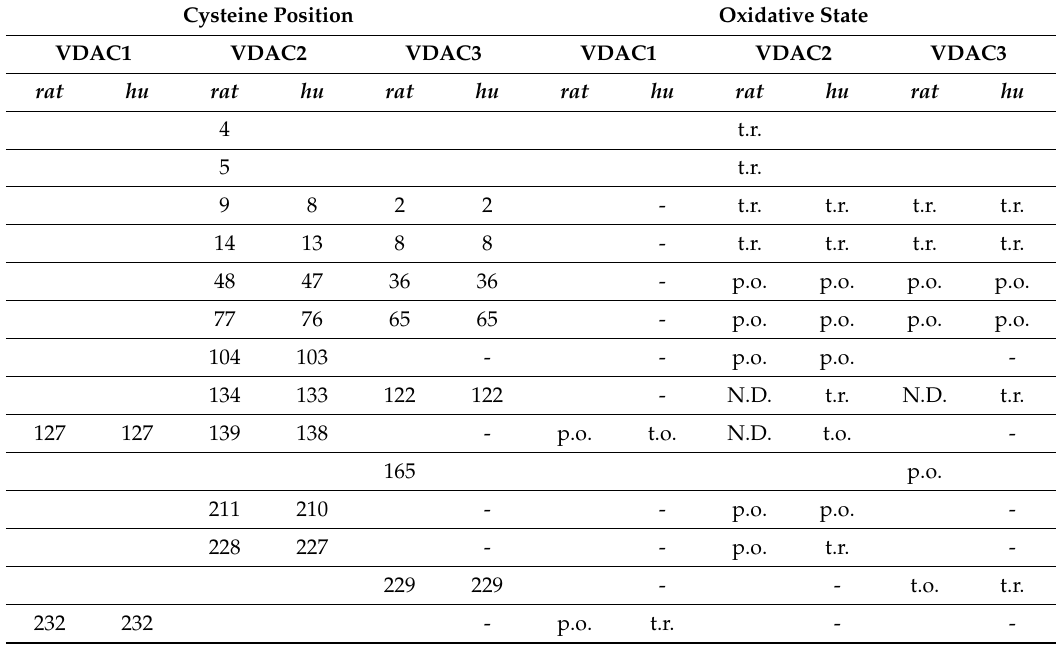
Table 4. Comparison of the oxidation state of cysteines in rat and human VDAC isoforms. p. o.: partially oxidized; t.o.: totally oxidized; t.r.: totally reduced; rat: VDACs from rat liver; hu: VDACs from human HAP1 cells. Cysteine residues are aligned in the same rows according to their presumed homology. Cysteine Position Oxidative State VDAC1 VDAC2 VDAC3 VDAC1 VDAC2 VDAC3 rat hu